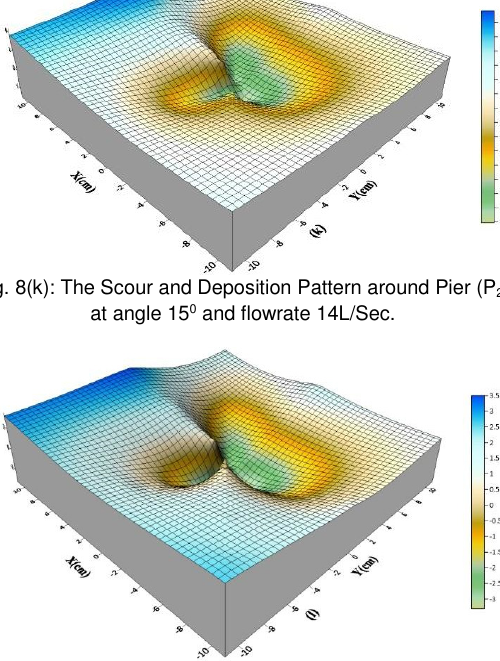
Fig. 8(l): The Scour and Deposition Pattern around Pier (P 2 ) at angle 15 0 and flowrate 18L/Sec. The green area denotes maximum scouring pattern